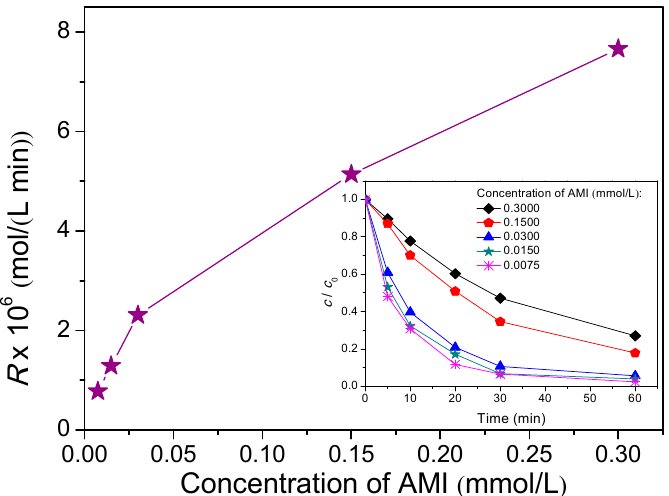
Figure 5. Effect of the initial AMI concentration on the photocatalytic degradation rate calculated for the first 20 min of irradiation in the presence of ZnO (1.0 mg/mL) and solar radiation. Inset represents the effect of initial AMI concentration on the kinetics of photocatalytic degradation.